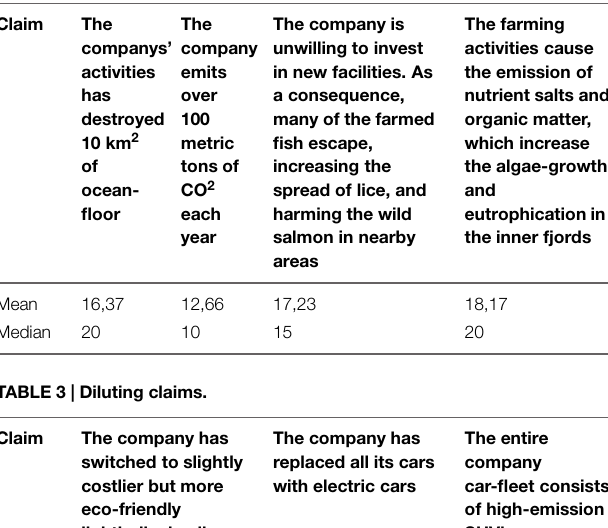
TABLE 2 | Evaluation of negative claims.